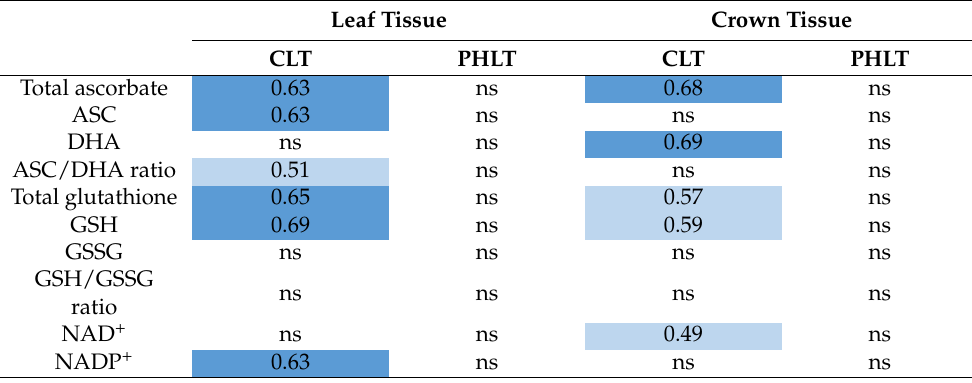
Table 1. Spearman coefficients (r values) of antioxidants with freezing tolerance throughout the experiment. Strong (r ≥ 0.6) and moderate (r ≥ 0.4) positive correlations are indicated by blue and light blue colours, respectively. Non-significant correlations ( p > 0.05) are marked as “ns”. Leaf Tissue Crown Tissue CLT PHLT CLT PHLT Total ascorbate 0.63 ns 0.68 ns ASC 0.63 ns ns ns DHA ns ns 0.69 ns ASC/DHA ratio 0.51 ns ns ns Total glutathione 0.65 ns 0.57 ns GSH 0.69 ns 0.59 ns GSSG ns ns ns ns GSH/GSSG ns ns ns ns ratio NAD + ns ns 0.49 ns NADP + 0.63 ns ns